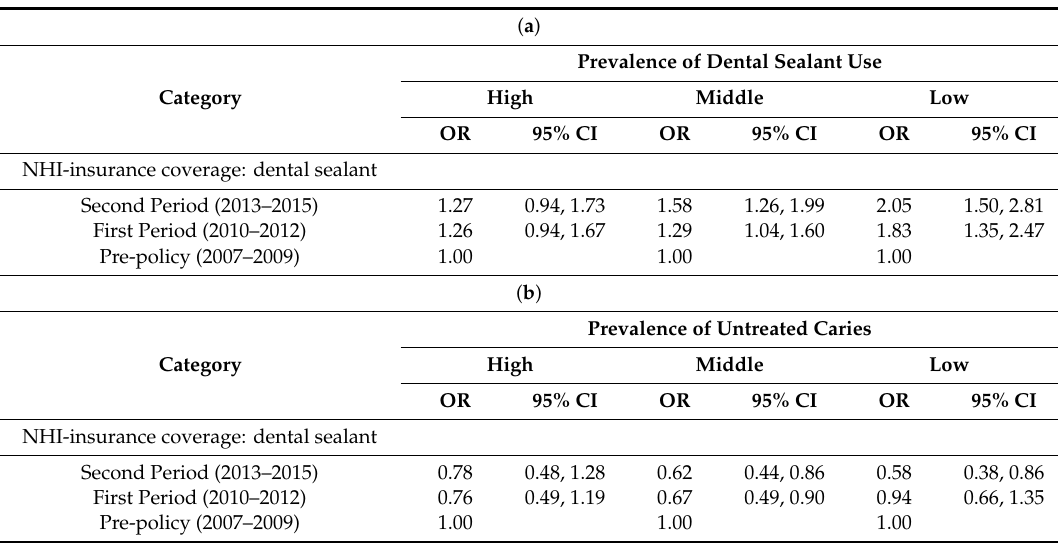
Table 4. ( a ) Odds Ratio for the prevalence of dental sealant use by household income; ( b ) Odds Ratio for prevalence of having untreated caries by household